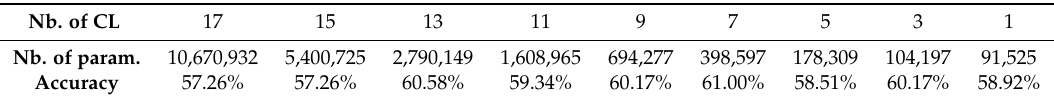
Table 3. Accuracies varied by the number of Convolutional Layers (CLs) and associated number of learnable parameters.